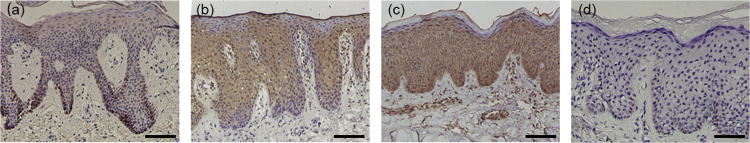
The occurrence and distribution of Cyr61 expression in skin lesion of patients with psoriasis vulgaris. The epidermal positive staining of Cyr61 varied from patient to patient: (a) darker staining in stratum basale, (b) darker staining in upper epidermal layers, (c) moderate staining in stratum spinosum, (d) isotype control. Bar 100 μm, Magnification ×100.